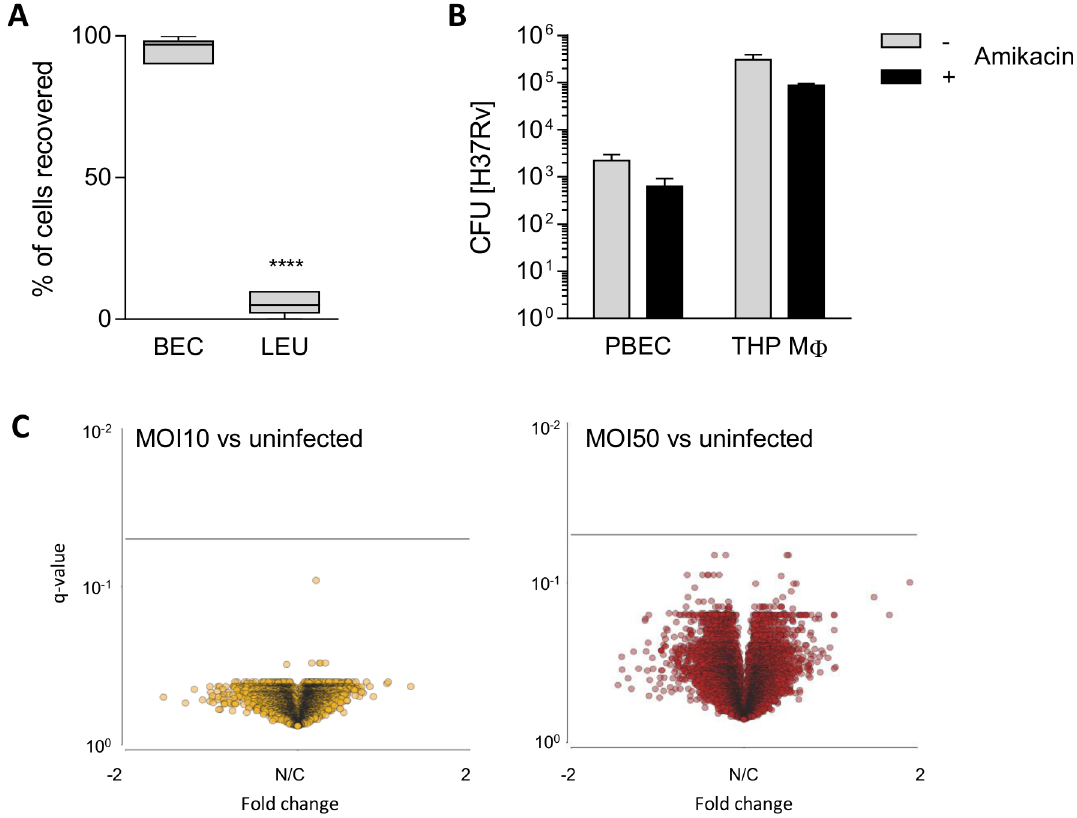
Fig 1. Epithelial cells are the major subset in the airway lining and are not permissive to Mtb infection. (A) Presence of total bronchialepithelial cells (BECs) and leukocytes (LEU) was measured ex vivo by differentialcell counts of bronchial brushingsderivedfrom the airway lining. Subsets are shown as % of total cells recovered from healthy volunteers (n = 17). Wilcoxon signed rank test was used to comparegroups. Boxplots show median and range. **** p < 0.0001.(B) PBECs (n = 4) and THP-1 M Φ (mean ± SD of 2 independentexperiments) were infected with Mtb H37Rv for 24h. To remove extracellularbacteria, 200 μ g/ml amikacinwas added for an additional2h where indicated.Mtb bacilliwere enumeratedby colony forming units (CFU). (C) Affymetrix HTA2.0 arrays were performed on PBECs (uninfected, MOI10 or MOI50, 24h) from 4 donors. The log 2 fold changecomparedto unstimulated PBECs and the associated FDR-adjustedq-valueare shown in volcano plots for MOI10 (left) and MOI50 (right). The solid black lines intersect at q-value of